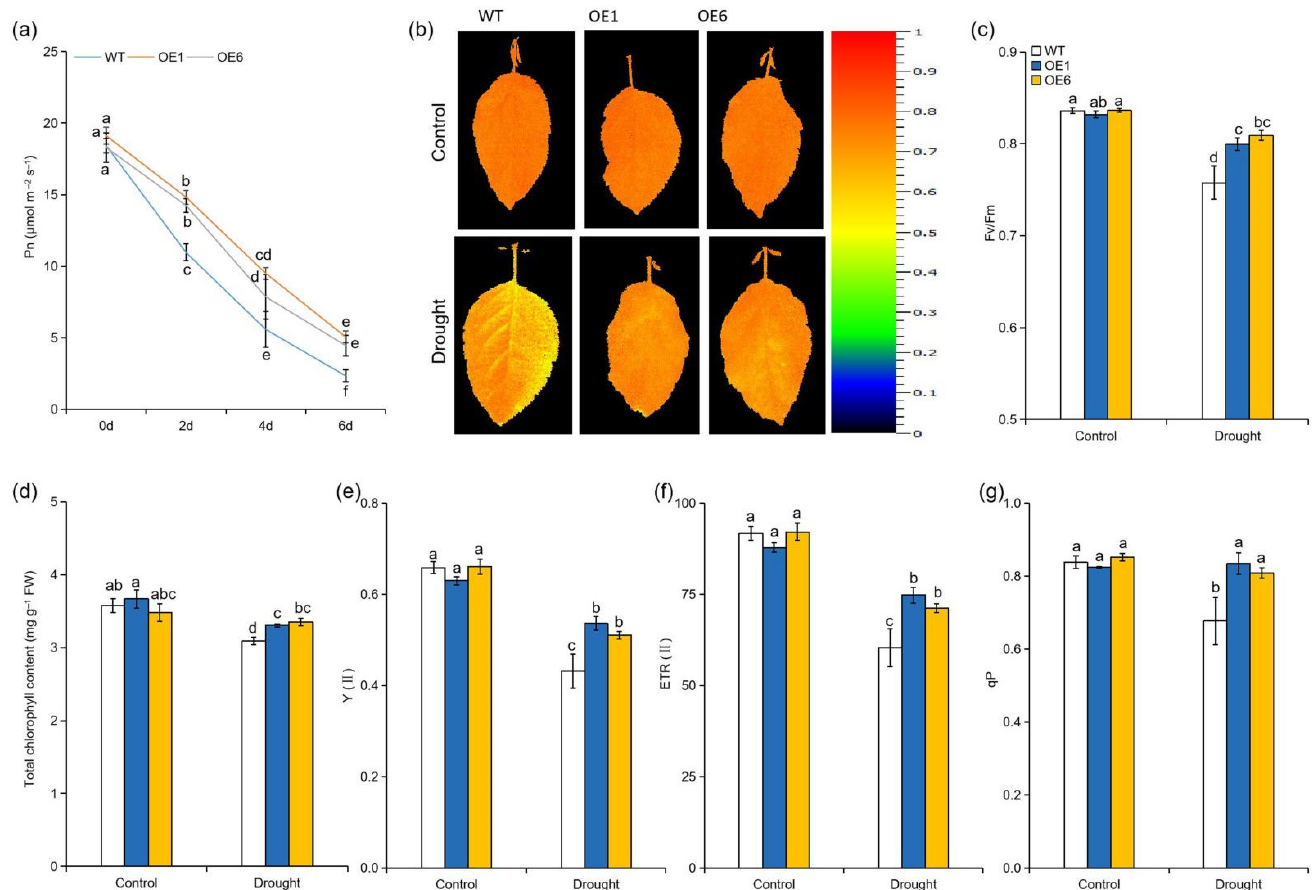
Figure 2. Effect of MdATG8i overexpression in apple on the photosynthetic and chlorophyll fluorescence parameters under drought stress. ( a ) Photosynthetic rate (Pn), ( b ) chlorophyll fluorescence images, ( c ) the maximum quantum yield of PSII (Fv/Fm), ( d ) total chlorophyll content, ( e ) the effective quantum yield of PSII [Y(II)], ( f ) the electron transport rate of PSII [ETR (II)], and ( g ) photochemical quenching (qP) of WT and MdATG8i OE plants with or without drought stress. The data are presented as means ± SD of three replicates. Values with different letters are significantly different ( p < 0.05, Tukey’s multiple range test).